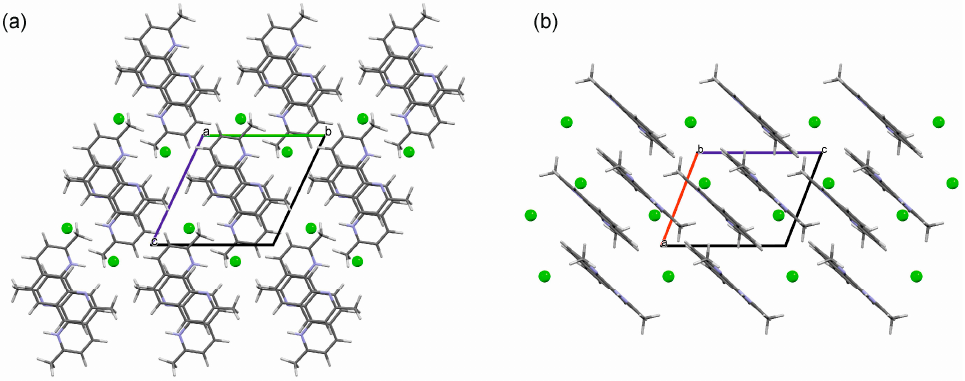
Figure 12. Packing diagrams of 2-I viewed along ( a ) the a and ( b ) the c crystallographic axes.